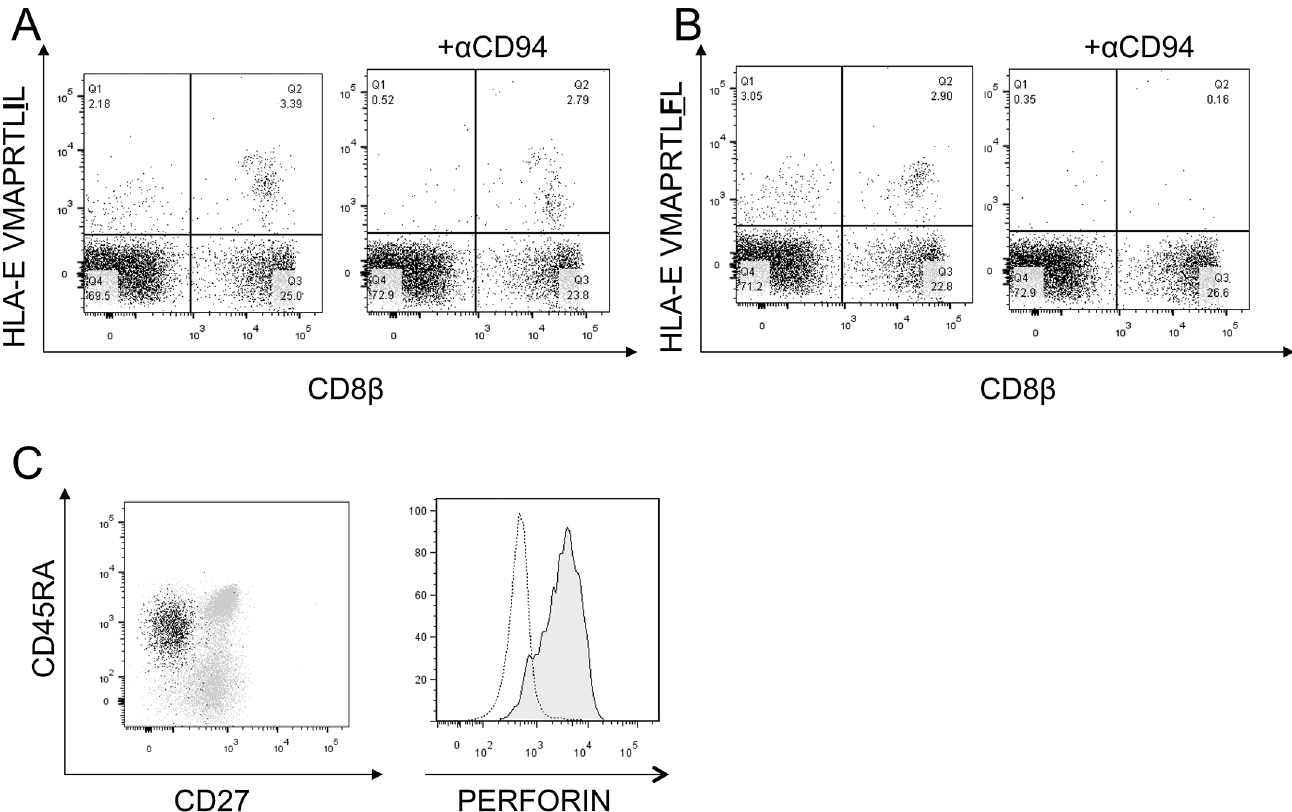
Fig 1. UL40-specific T cells isolated from a healthy donor have an effector memory phenotype. Peripheral blood mononuclear cells (PBMC) were isolated from a healthy donor and were stained with HLA-E tetramers refolded with either the leader sequence from HLA-C * 03 (HLA-E-VMAPRTL I L, A) or HLA-G (HLA-E-VMAPRTL F L, B) in the presence (+ α CD94) or absence of a blocking antibody to CD94. Cells were also stained with antibodies to CD8 β , CD27 and CD45RA (C left panel: tetramer positive, CD8 β + cells: black, tetramer negative CD8 β +: gray) before permeabilising and staining with an antibody to perforin (C right panel, tetramer positive, CD8 β + cells: solid histogram, tetramer negative CD8 β +: dotted line). Numbers in each quadrant reflect percentages of live